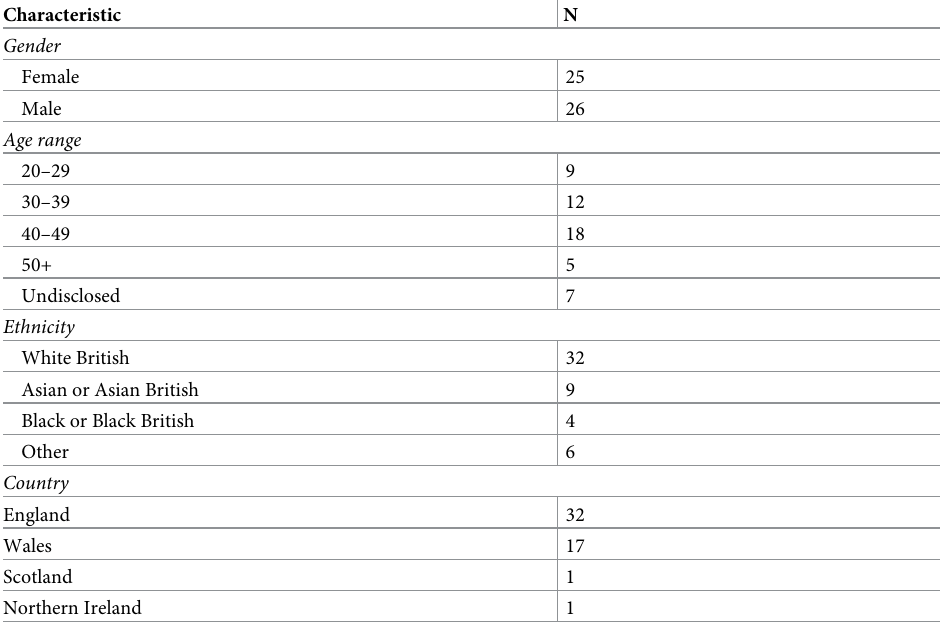
Table 1. Demographic details reported by